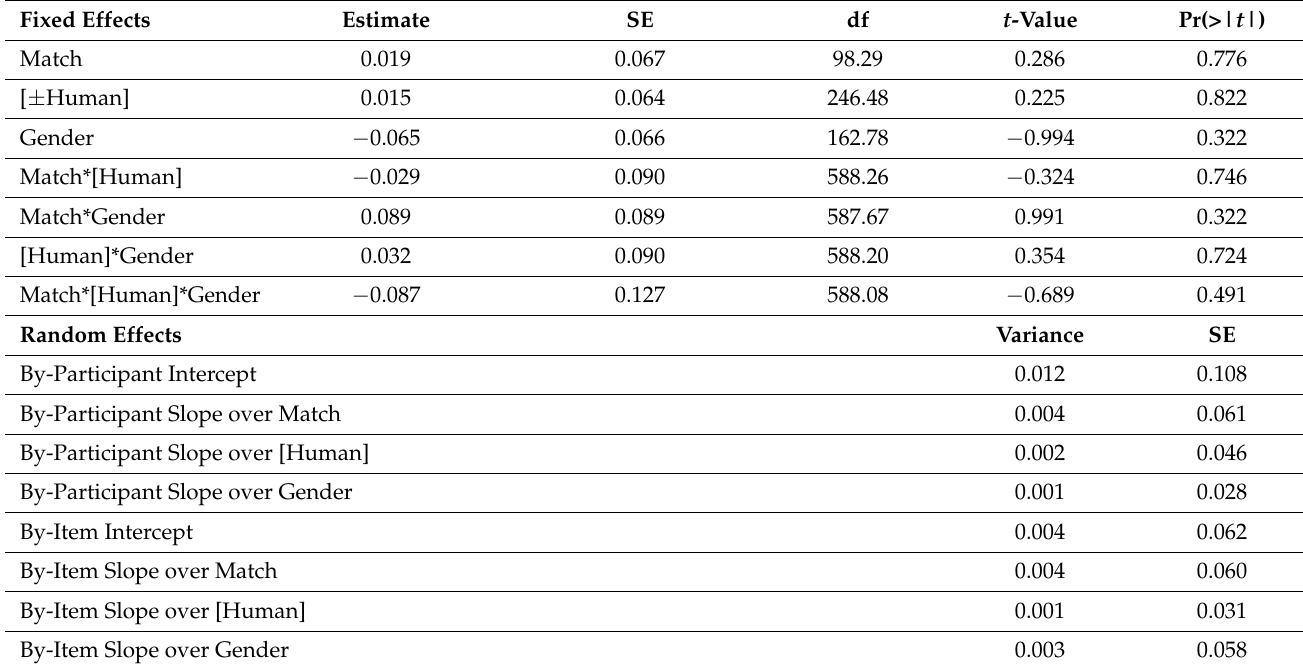
Table A3. Linear mixed-effects model, postverbal region (Region 6-SPR), L2 group.